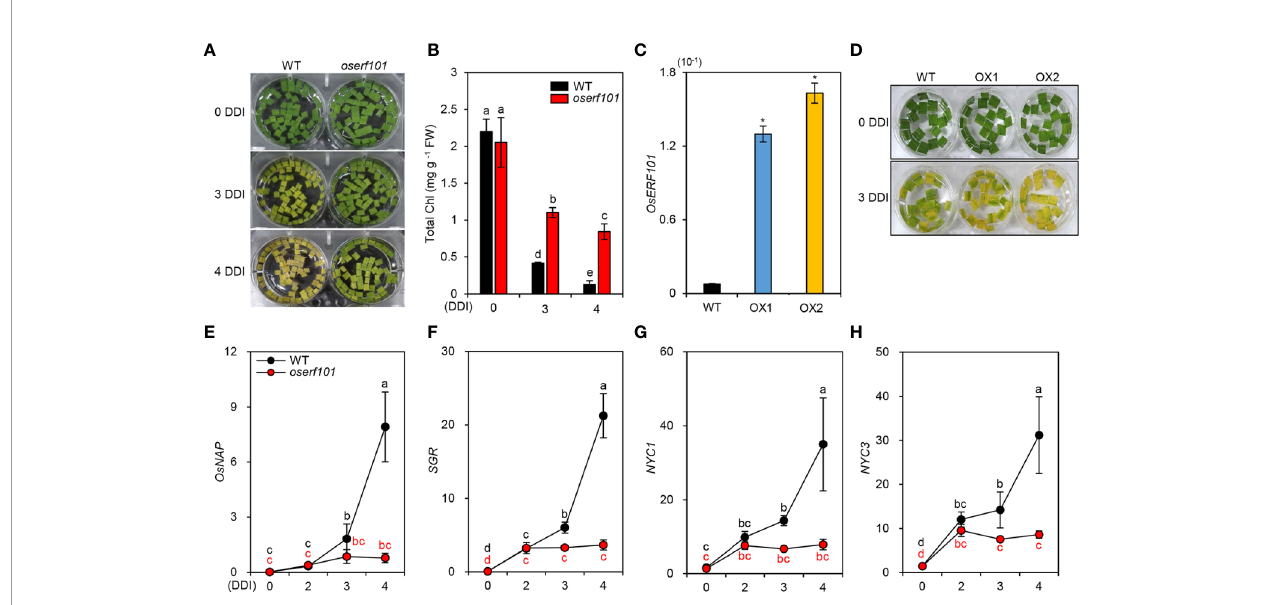
FIGURE 3 | The oserf101 mutant exhibited delayed leaf yellowing during dark-induced senescence (DIS) conditions. (A, B) Detached leaves of 3-week-old WT and oserf101 plants grown in the greenhouse under natural long-day conditions (>14 h light/day) were incubated in 3 mM MES buffer (pH 5.8) with the abaxial side up at 28°C under complete darkness. The visual phenotypes (A) and total chlorophyll (Chl) contents (B) were observed after 0, 3, and 4 days of dark incubation (DDI). Different letters indicate signi fi cantly different values according to a one-way ANOVA and Duncan ’ s least signi fi cant range test ( p < 0.05). (C) Expression of OsERF101 measured in the leaves of WT and OsERF101 -overexpressing ( OsERF101 -OX) transgenic plants (OX1, OX2) grown in the greenhouse for one month. (D) Detached leaves of 1-month-old OsERF101 -OX plants exhibited accelerated leaf yellowing at 3 DDI. (E – H) Altered expression of OsNAP and chlorophyll degradation genes in detached leaves of 3-week-old WT and oserf101 seedlings during DIS. Total RNA was isolated from detached leaves at 0, 2, 3, and 4 DDI. The transcript levels of OsERF101 (C) , OsNAP (E) , and chlorophyll degradation genes (F – H) were determined by qRT-PCR and normalized to that of OsUBQ5 (Os01g22490). (C) Asterisks indicate statistically signi fi cant differences between WT and OsERF101 -OX plants, as determined by Student ’ s t-test (* p < 0.05). (E – H) Different letters indicate signi fi cantly different values according to a one-way ANOVA and Duncan ’ s least signi fi cant range test ( p < 0.05). Mean and standard deviations were obtained from at least three biological samples. Experiments were repeated twice with similar results. FW, fresh